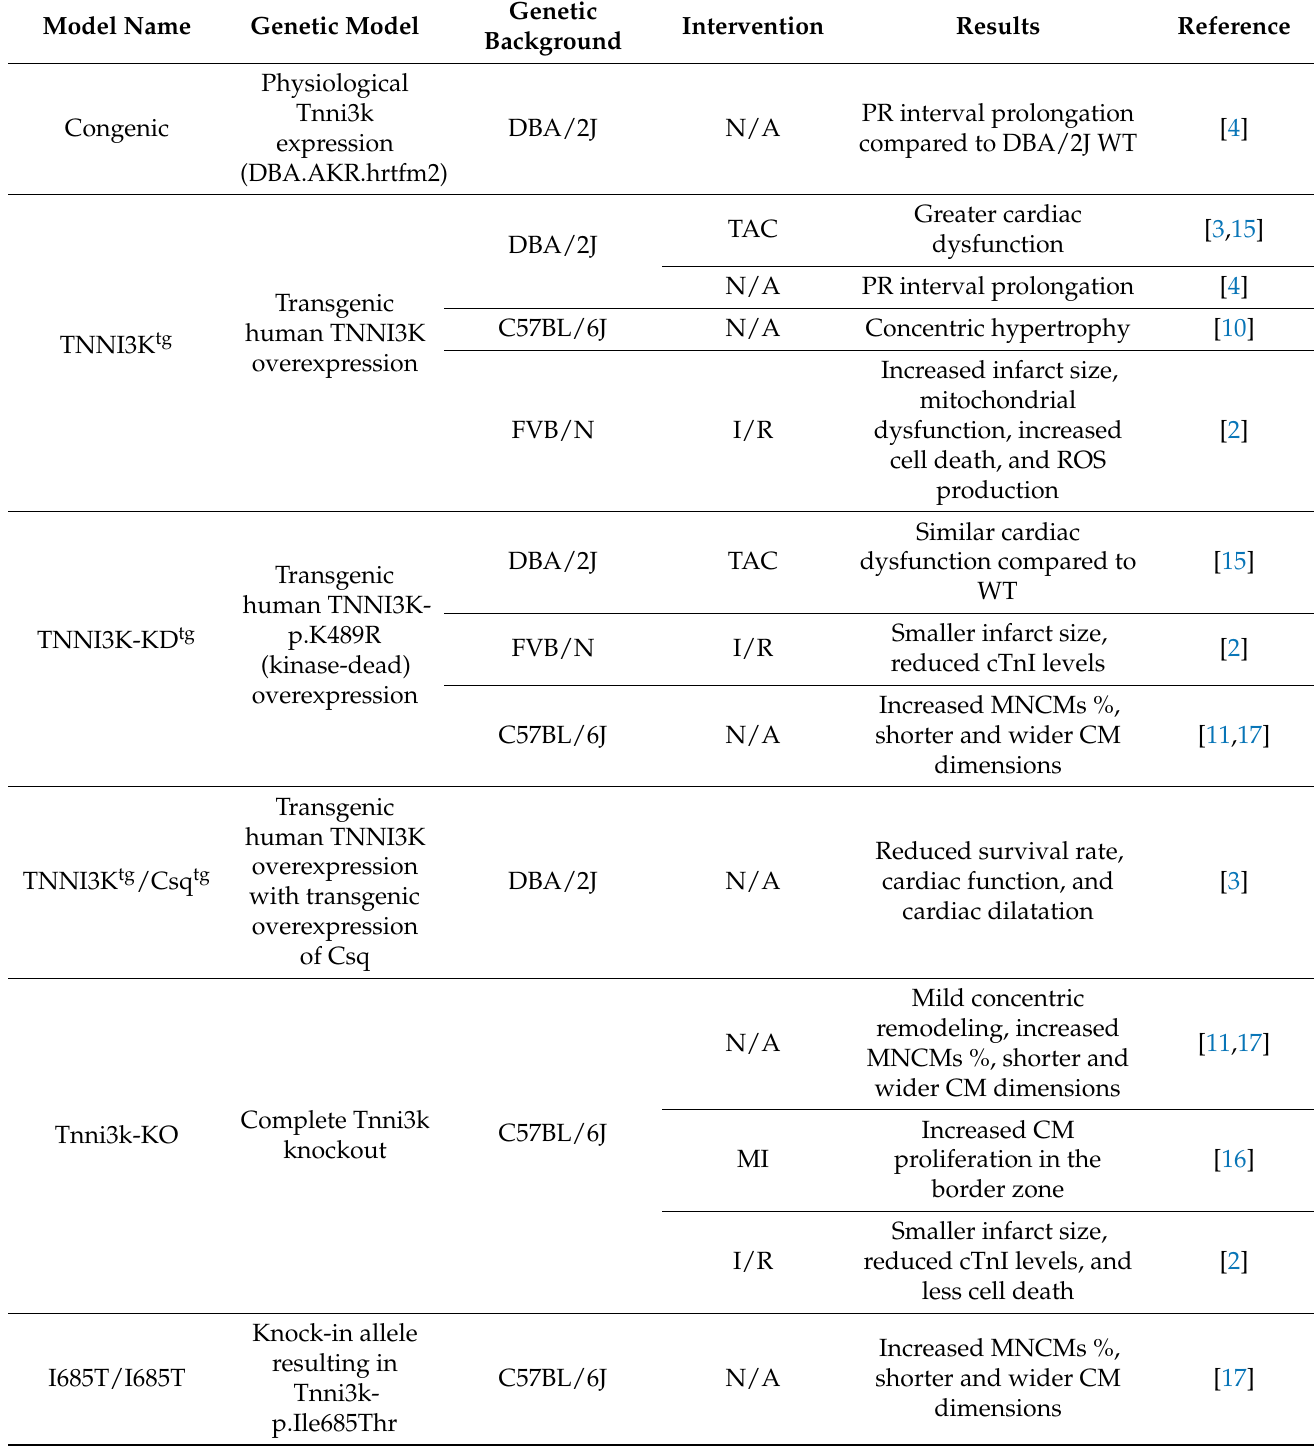
Table 1. Overview of discussed mouse models. I/R: Ischemia/reperfusion; MI: Myocardial infarction; TAC: Transverse aortic